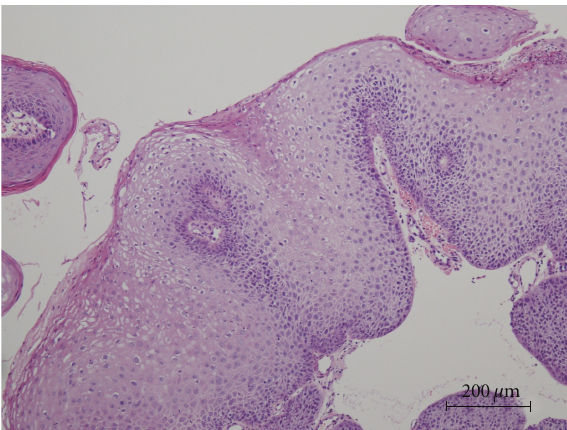
Figure 3: Hematoxylin and eosin staining of bladder urothelial inverted papilloma (HPV negative).